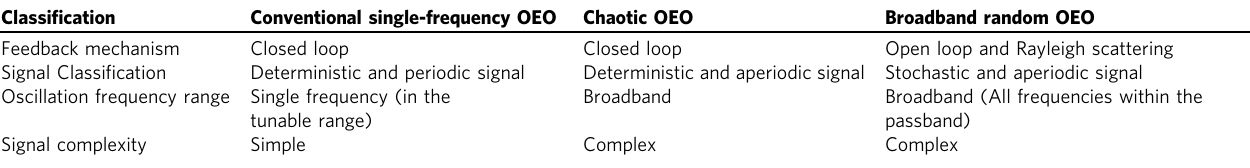
Table. 1 The difference between the conventional single-frequency OEO, the chaotic OEO and the broadband random OEO. Classi fi